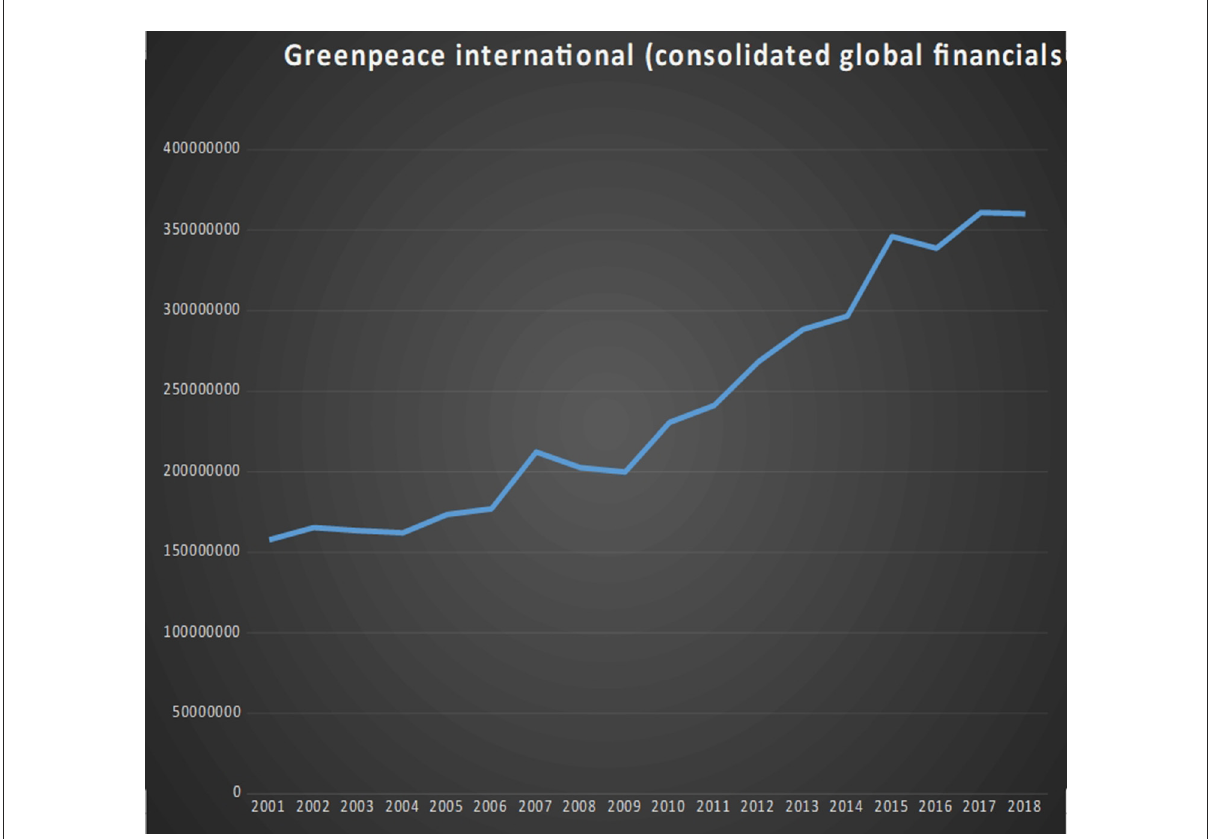
keep making Pindaric flights theorizing idyllic cosmopolitan